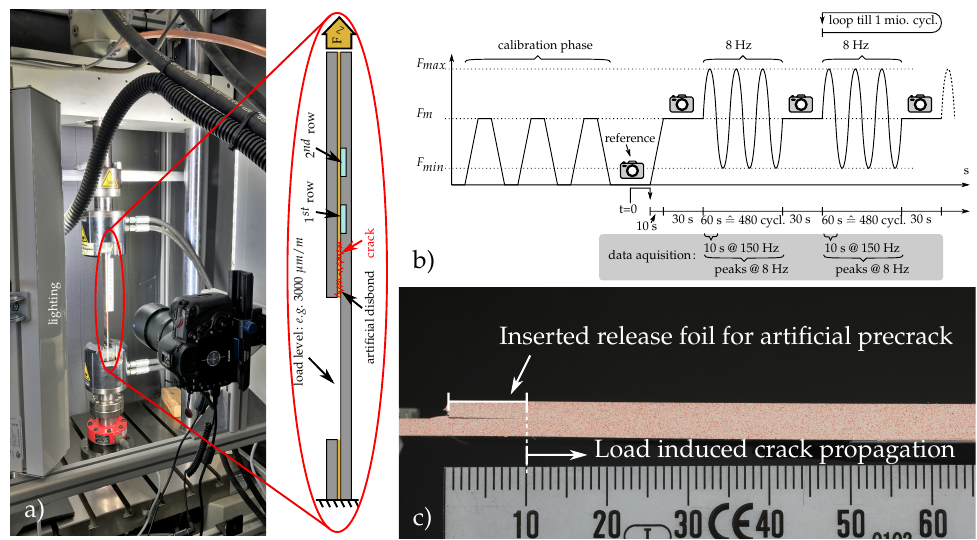
Figure 3. Dynamic fatique testing overview: ( a ) tensile test bench with enlarged CLS specimen sketch; ( b ) program overview of dynamic loading; ( c ) sideview picture after calibration run.